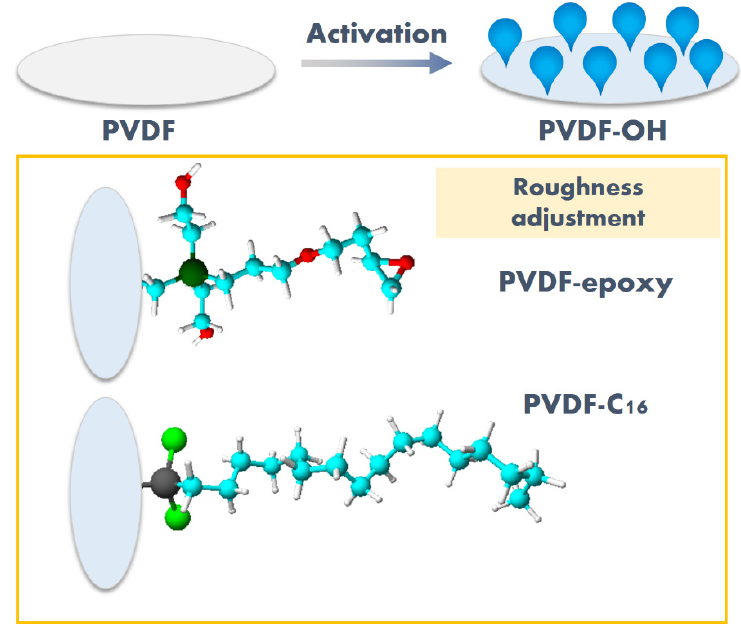
Figure 1. The idea of the work—functionalization of activated (PVDF-OH) materials to tune material properties. PVDF-epoxy—membrane modified with 3-glycidyloxypropyl)triethoxysilane, PVDF- C 16 —membrane modified by trichloro(octadecyl)silane.